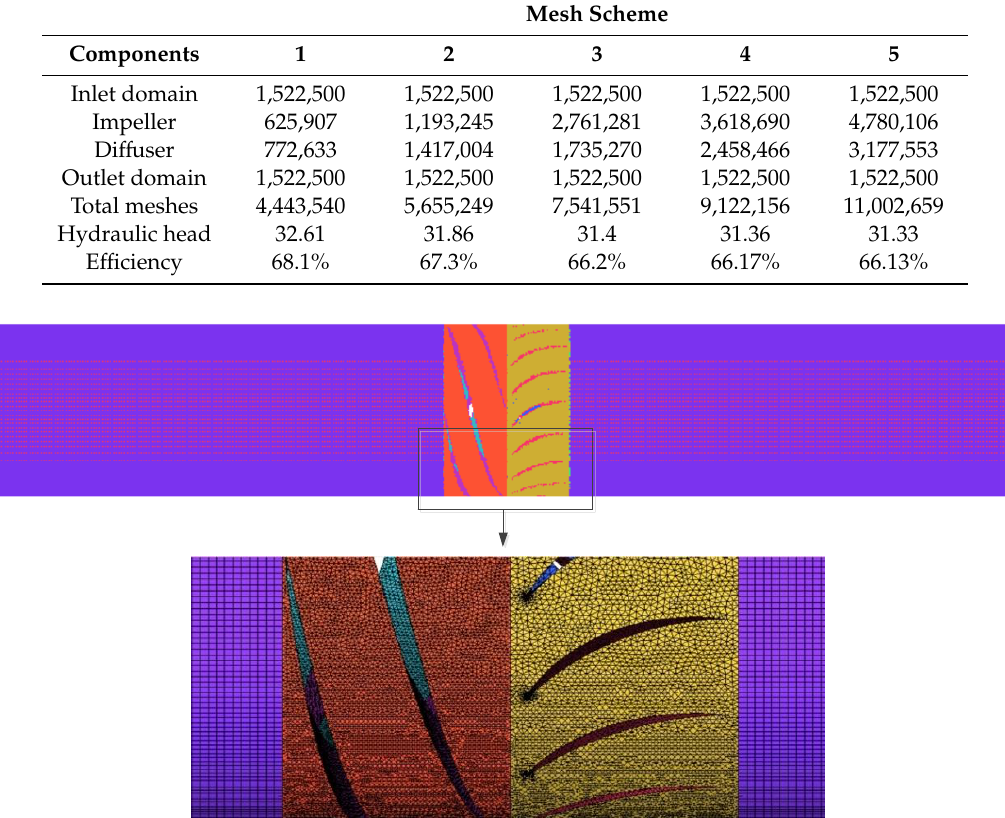
Figure 2. Grids of a single compression unit.